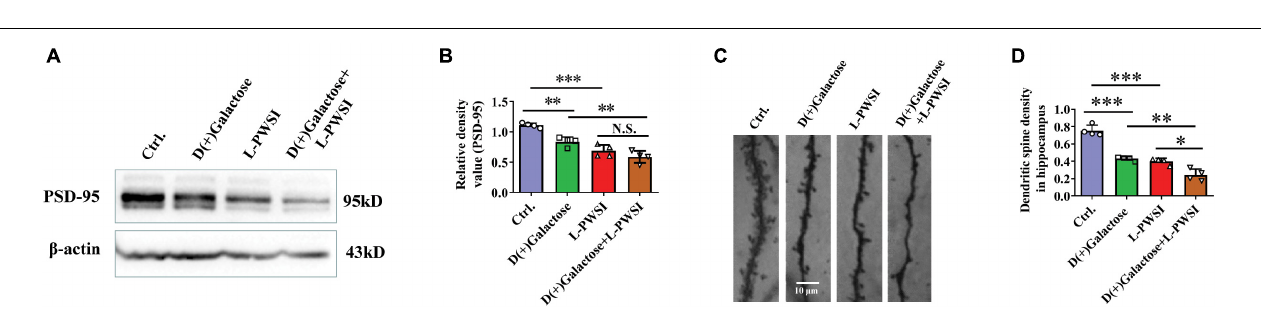
FIGURE 5 | Treatment with long-term post-weaned social isolation (L-PWSI) and D(+)Galactose decreased PSD-95 and dendritic spine density. Representative micrographs (A) of Western blot (protein expression) with densitometry analysis PSD-95 (B) in the hippocampus. The grouping of gels/blots is cropped from different parts of the same gel. (C) Representative micrographs of dendrites (D) and dendritic spines density in the hippocampus. Each data column represents the mean ± SEM obtained from 4 brain samples. ∗ represents p < 0.05; ∗∗ represents p < 0.01; ∗∗∗ represents p < 0.001; N.S., represents no significance.